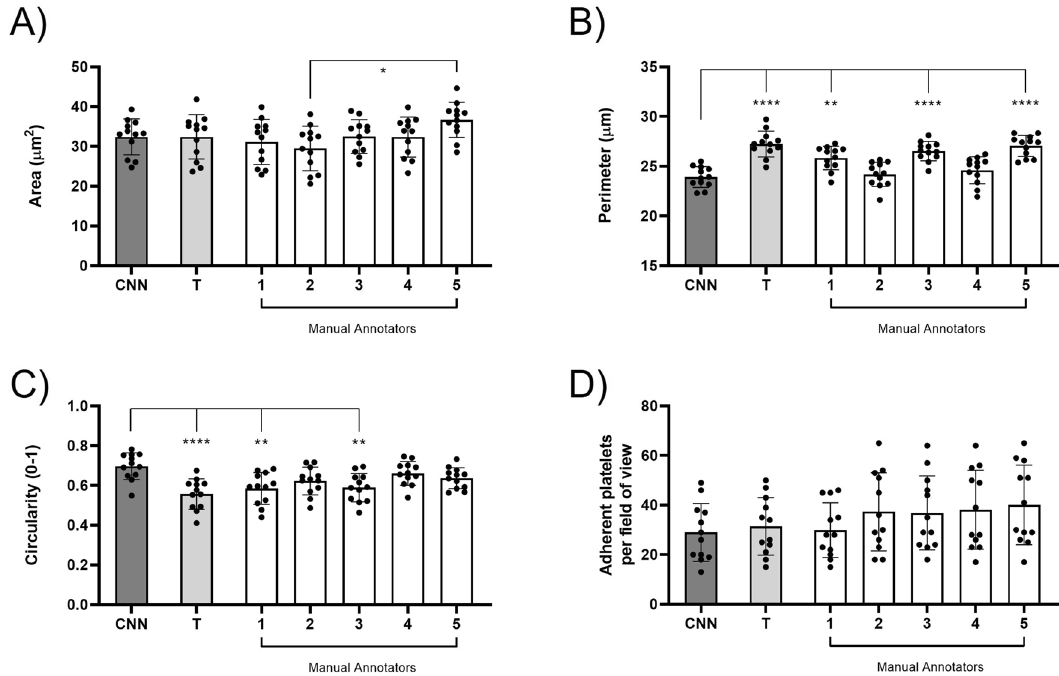
( D ) in 12 images. The automated output of the CNN was compared to a trainer (T) and manual annotators (1–5). The mean ± SD of the 12 images was plotted and analysed using one-way ANOVA with Bonferroni